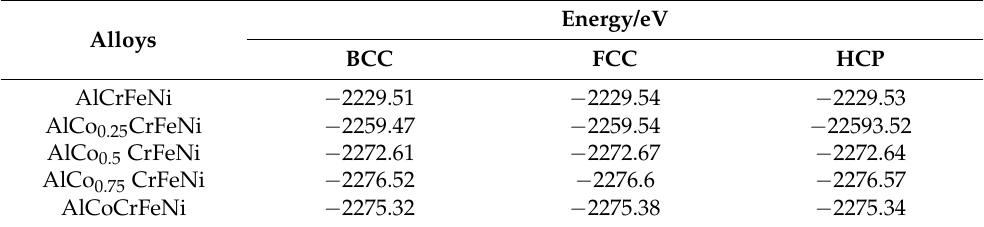
Table 2. The crystal energies of different phase structures (BCC, FCC and HCP phases)